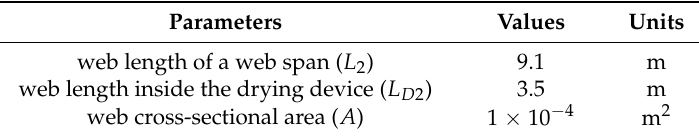
Table 1. Mechanical Parameters of the Printing Subsystem.